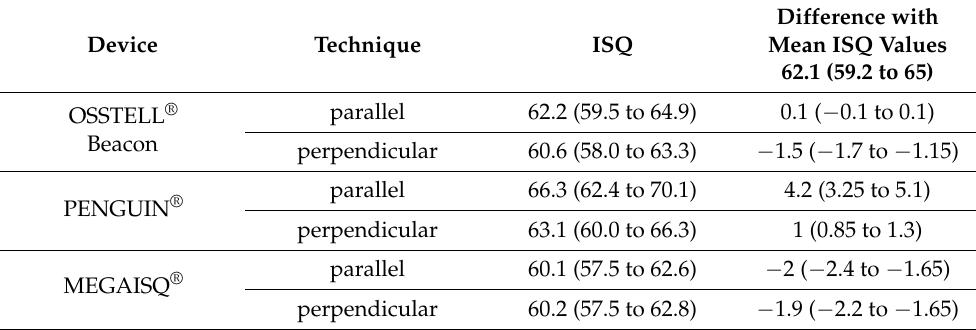
Table 1. Mean values (95% CI) of implant stability quotient (ISQ) according to the device and the orientation.